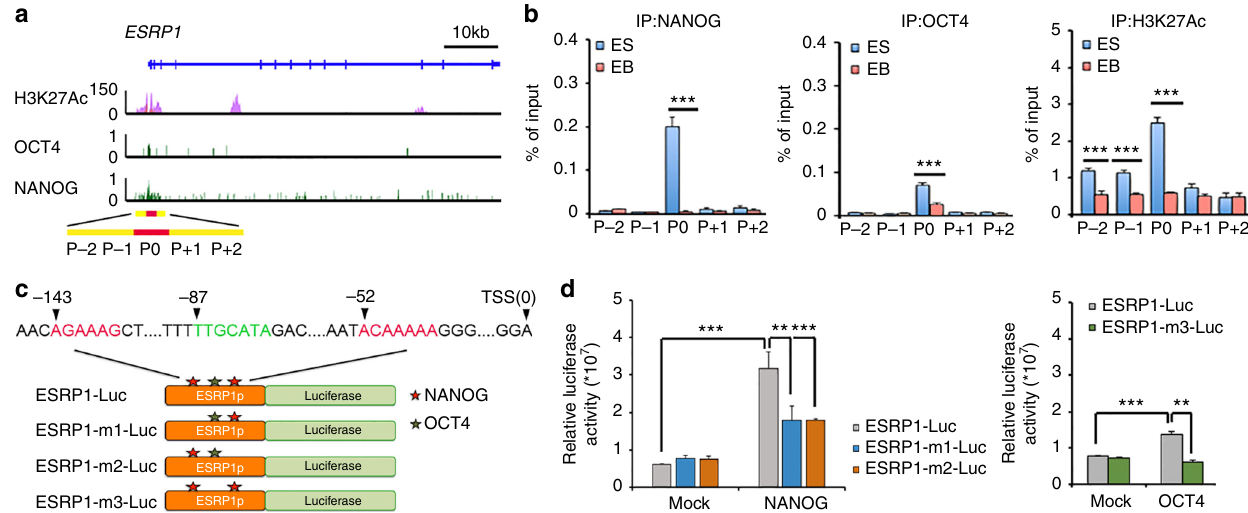
Fig. 8 NANOG and OCT4 regulate ESRP1 expression in hESCs. a ENCODE ChIP-Seq data for NANOG and OCT4 occupancy, and H3K27Ac modi fi cations were aligned to the ESRP1 promoter, de fi ned as − 1 kb to +1 kb relative to the transcription start site. The y axis represents the intensity of ChIP-Seq reads. The highest NANOG and OCT4 binding peaks on the ESRP1 promoter are labeled as P0 (red bars; Chr8: 95653024 – 95653560), and four fl anking regions within − 1 kb to +1 kb (yellow bars) of P0 are labeled P − 1, P − 2, P+1, and P+2. b ChIP fragments containing the NANOG and OCT4 binding peak, or its four fl anking regions, were quanti fi ed in hESCs and embryoid bodies (EBs) by qPCR using primers speci fi c for P0, P+1, P+2, P − 1, and P − 2, respectively (Supplementary Table 1), and normalized to the input genome used in ChIP. c Schematic illustrating luciferase reporters containing an ESRP1 promoter (ESRP1-luc), ESRP1-luc with deleted NANOG binding sites (ESRP1-m1-luc and ESRP1-m2-luc), and ESRP1-luc with a deleted OCT4 binding site (ESRP1-m3- luc). d Luciferase reporter analysis showing the luciferase activity of ESRP1-luc, ESRP1-m1-luc, ESRP1-m2-luc, and ESRP1-m3-luc in 293 T cells ectopically expressing NANOG (left panel) or OCT4 (right panel). Quantitative data from three independent experiments is presented as mean ± SD (error bars). P